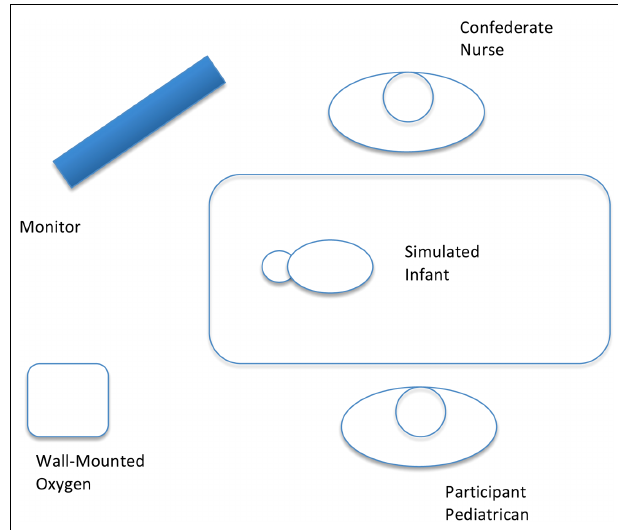
FIGURE 1 | Schematic showing the location of the various areas of interest (AoI), relative to the participant.